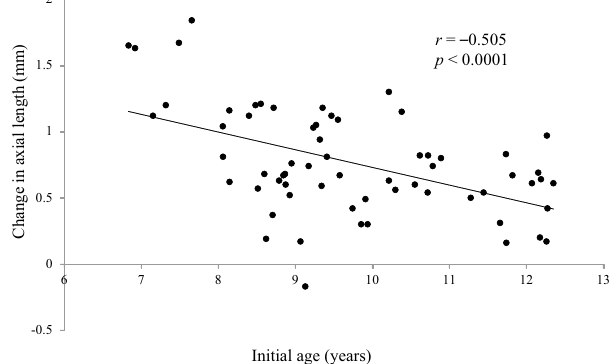
Figure 3. Scatterplots showing the initial age vs the change in axial length over 2 years. There was a significant correlation between the parameters (Pearson correlation coefficient; r = − 0.505, P <